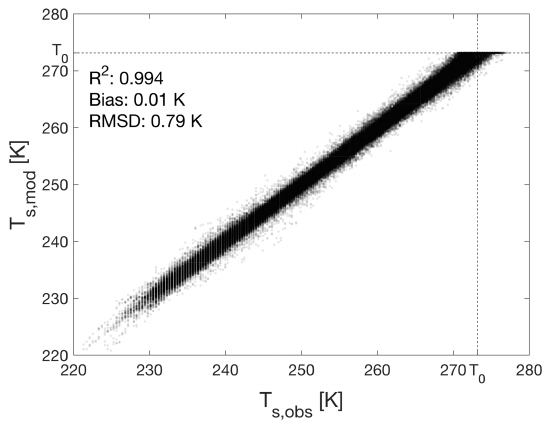
Figure 4. Daily values of modelled vs. measured T s for the parame- ter settings used in this study: z 0 , m = 1 . 65mm, ρ s , 0 = 280kgm − 3 .